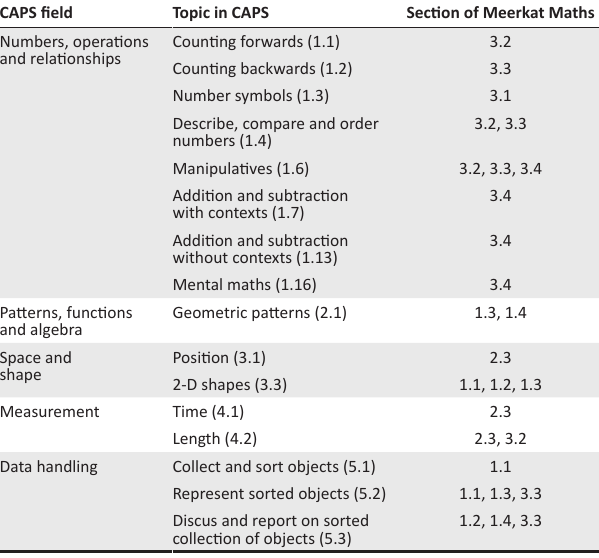
TABLE 2: Comparison of Curriculum Assessment Policy Statements and Meerkat